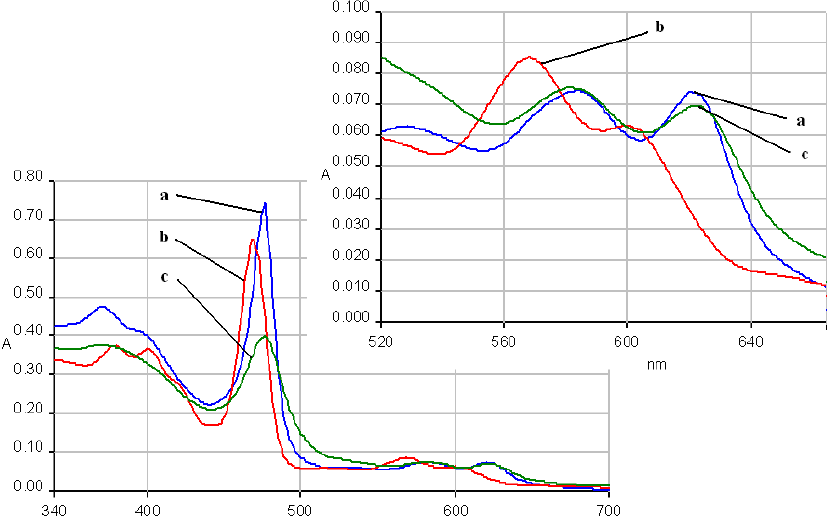
Figure 6. UV-Vis spectra. The influence of pH on the species of 2b in a THF/water system. Curve a: 2b in pure THF; curve b: pH = 2.5; curve c: pH = 11. Region of III and IV bands is presented in